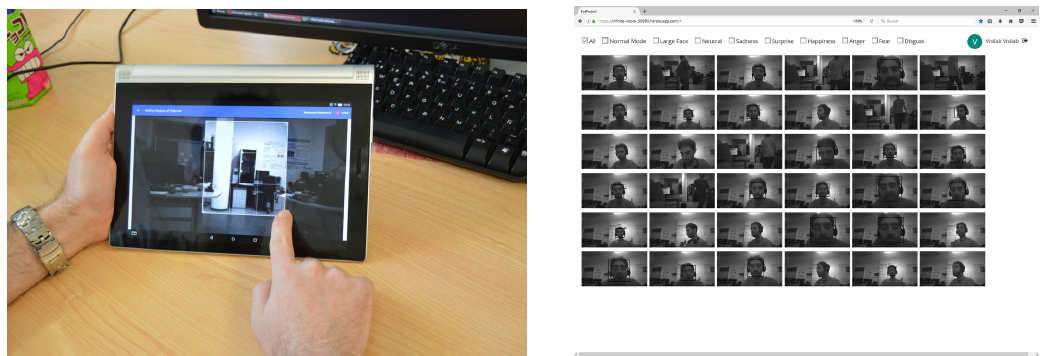
Figure 23. Left: defining a region of interest for motion detection. The region configured is sent to the EoT device through MQTT over WiFi communication. Right: access to captured images from a PC web browser. The images were previously retrieved from the EoT device and uploaded to the cloud